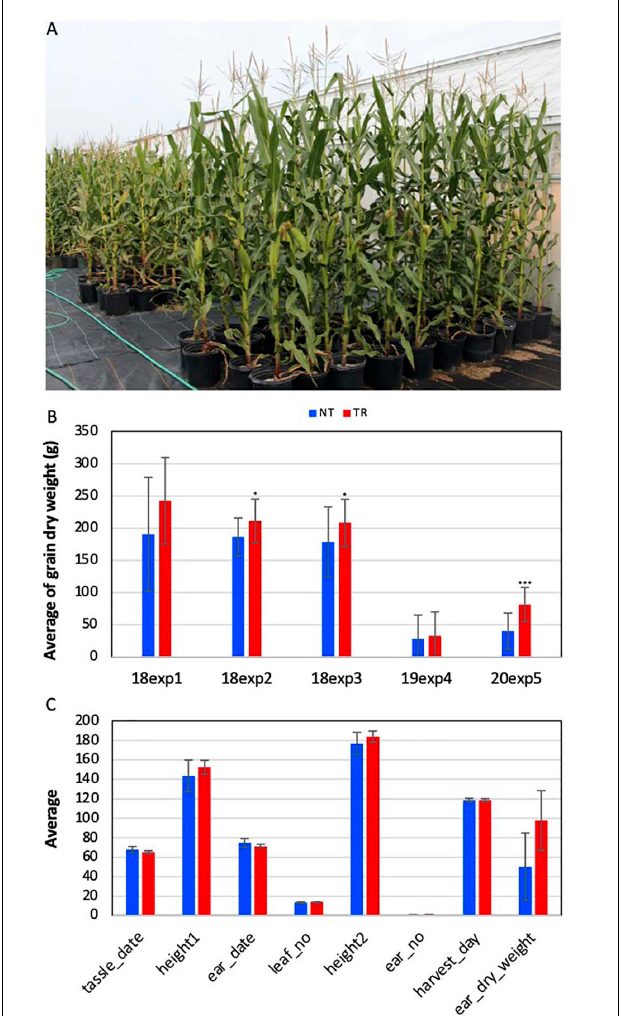
FIGURE 2 | Phenotype assessment of transgenic VcSOC1K -CX (TR) and nontransgenic null segregant (NT) maize plants of BC 1 and BC 2 lines. The BC 1 plants were evaluated in three experiments in 2018 [i.e., 18exp1 (No. of NT = 7, No. of TR = 10), 18exp2 (No. of NT = 25, No. of TR = 16), and 18exp3 (No. of NT = 38, No. of TR = 15)] and one experiment (19exp4, No. of NT = 44, No. of TR = 40) in 2019. The BC 2 plants were evaluated in one field test (20exp5, No. of NT = 87, No. of TR = 86) in 2020. (A) BC 1 plants randomly grown for phenotyping. (B) Averages of grain dry weight per plant. (C) Phenotypic data of all BC 2 plants. Tassle date: Days from sowing to the appearance of tassle. Height1: Plant height at the time of tassel appearance. Ear date: Days from sowing to the appearance of silk. Leaf no: Total number of leaves of a mature plant. Height2: Plant height at the time of harvest. Ear no: Total number of ears of a mature plant. Harvest day: Days from sowing to harvest. Ear dry weight: Dry weight of the ears from each plant. Bars